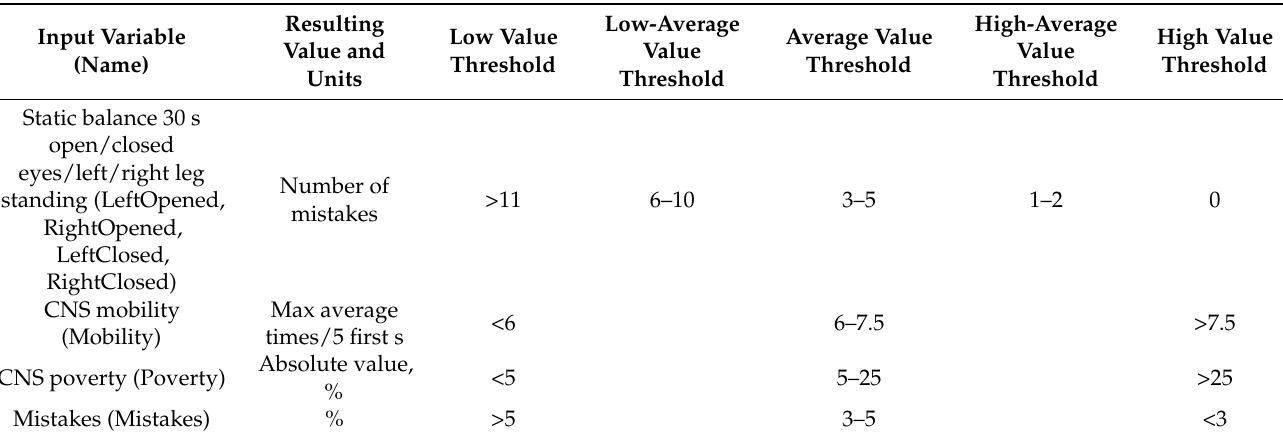
Table 5. Measured parameters and values for the nervous system evaluation in the proposed expert